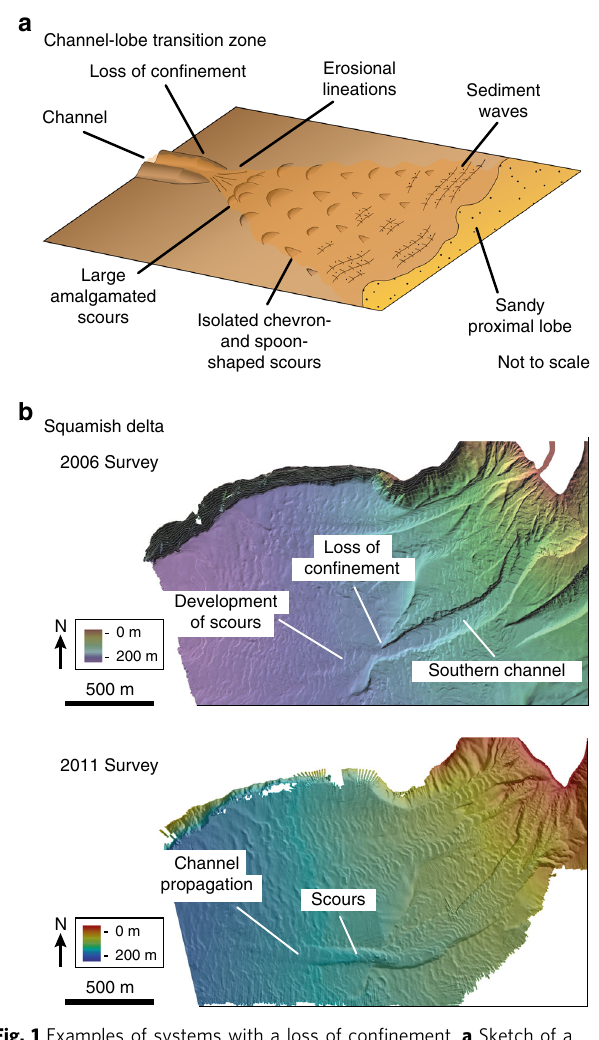
Fig. 1 Examples of systems with a loss of con fi nement. a Sketch of a channel-lobe transition zone based on bathymetrical surveys. Modi fi ed from ref. 13 . b The Squamish Delta. In the upper bathymetry map, the channel termination is marked by a rapid loss of con fi nement 43 . The lower bathymetry map was obtained 5 years later and shows how erosion has led the propagation of the channel by ~400 m